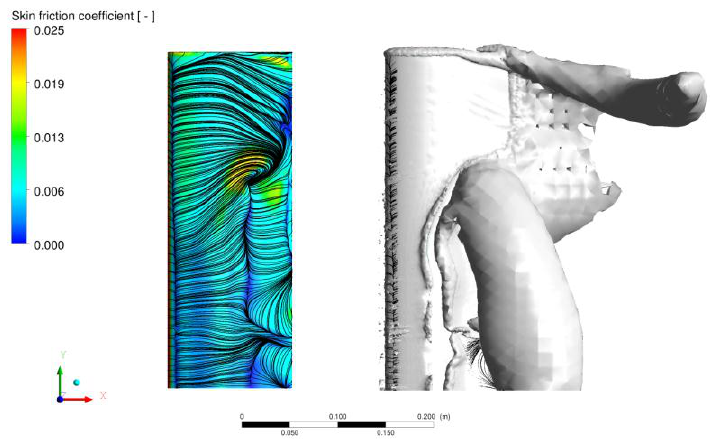
Figure 10. Close up illustration of the Omega vortex. The left side presents the blade intrados at 180 o azimuthal angle, colored by the skin friction coe ffi cient, in which the skin friction lines are displayed. The right side exhibits the corresponding 60 Hz vorticity iso-surface. It is clearly seen that the Omega vortex originates from a focus singular point and appears in company of a tip